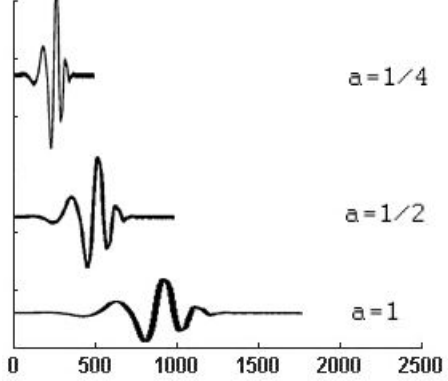
Figure 2. Example of the impact of changes in the scale factor on the wavelet [4].